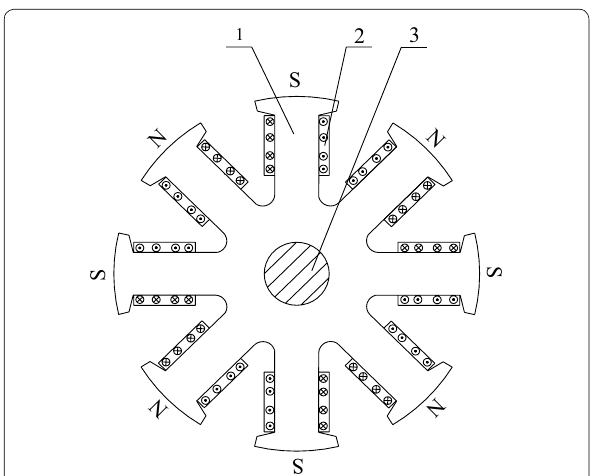
Figure 4 Structure diagram of salient-pole electrical excitation rotor. 1: Salient-pole rotor core; 2: Electric excitation winding; 3: Shaft